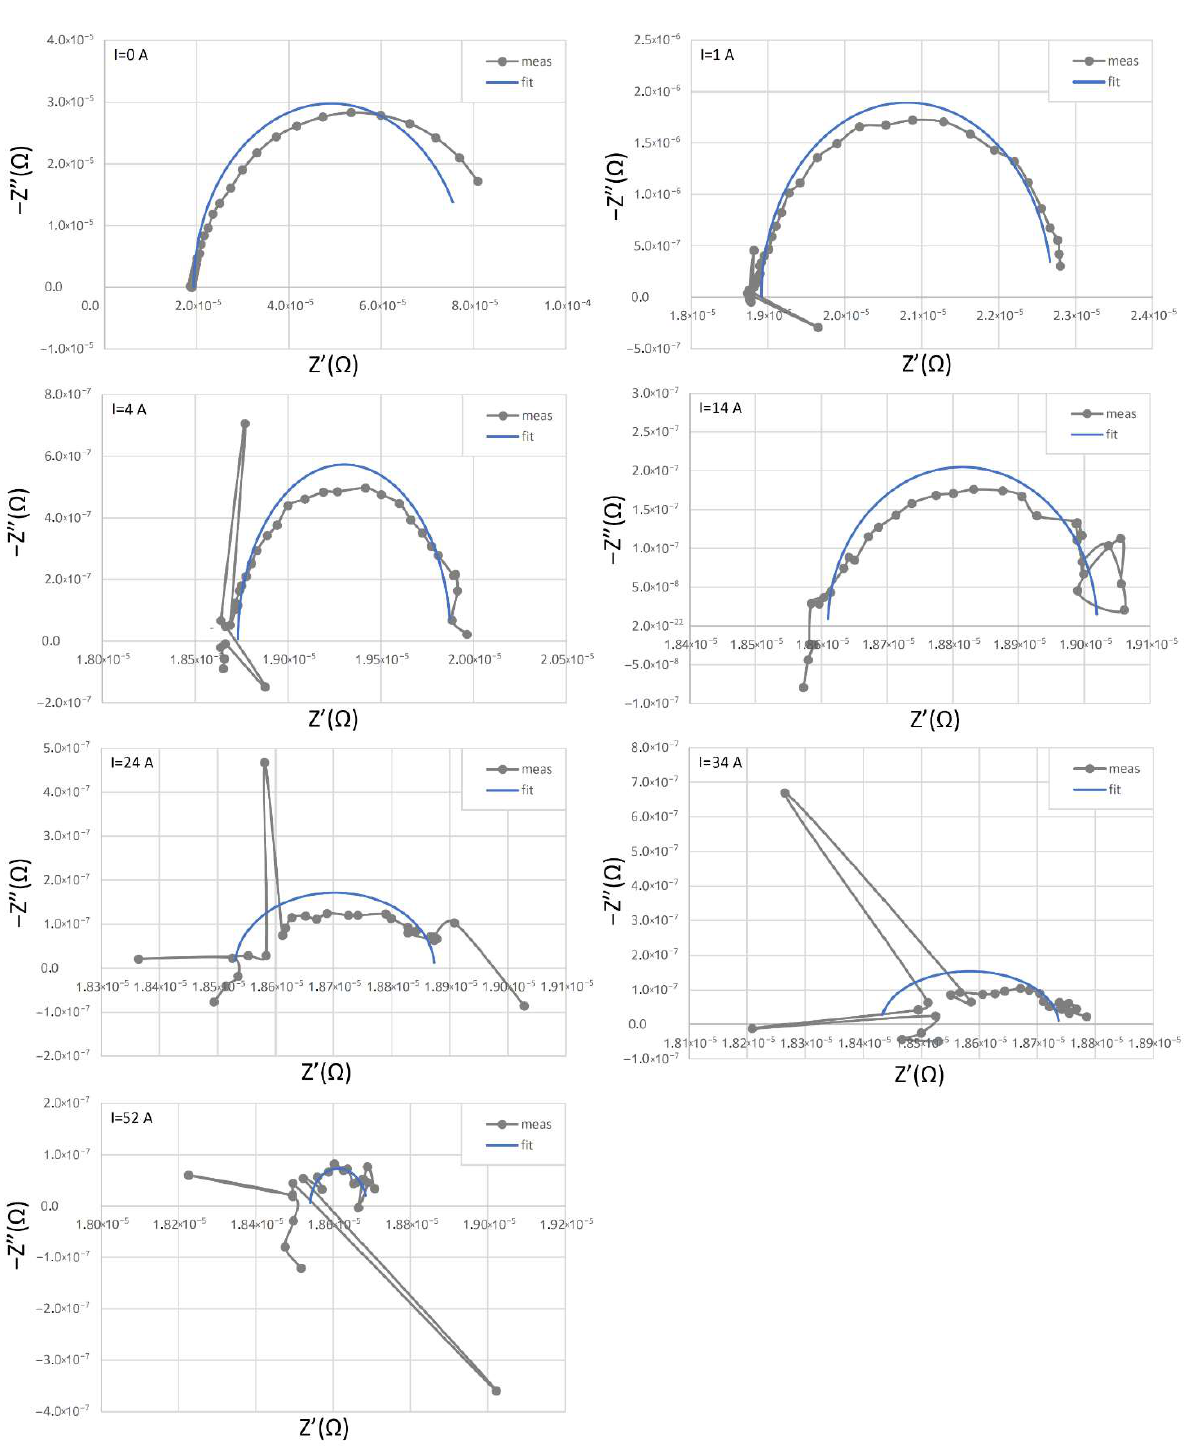
Figure 5. Raw EIS curve along with its fitting curve for each current. Equation (20).